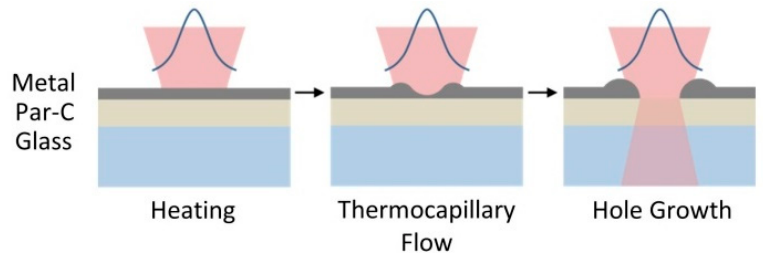
Figure 1. The mechanism for direct-write dewetting using a focused near-infrared (NIR) laser radiation